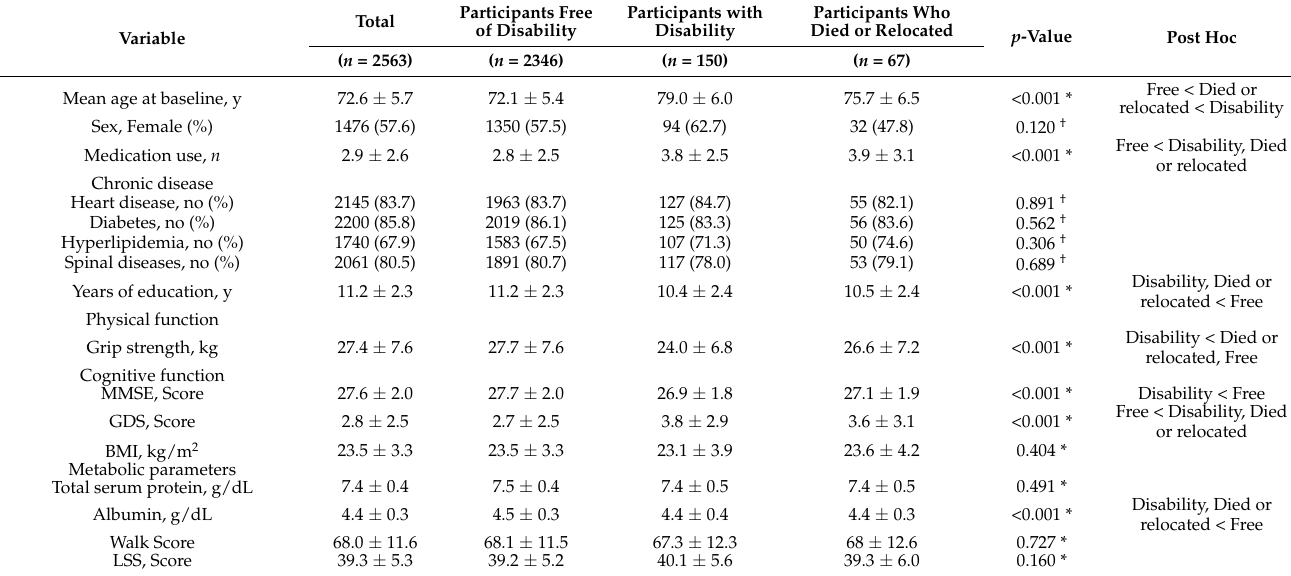
Table 1. Baseline characteristics of study participants by follow-up